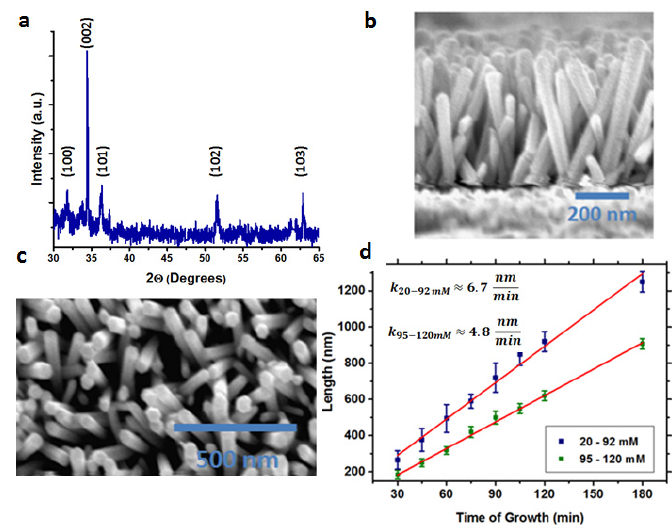
Figure 2. ( a ) XRD of the ZnO nanowires (NWs); ( b ) SEM cross section of the ZnO NWs grown at 90 mM and 75 min; ( c ) SEM top view of the ZnO NWs grown in the same conditions as in Figure 2b; ( d ) The NWs length as a function of the growth time for the two different concentration regimes. The diameter of the ZnO NWs is altered by changing precursor concentration, as indicated in Figure 3b. If the precursor concentration is increased, the diameter increases. It can be observed that from 20 to 92 mM there is a slow increase in the NWs diameter (linear increase); this was also